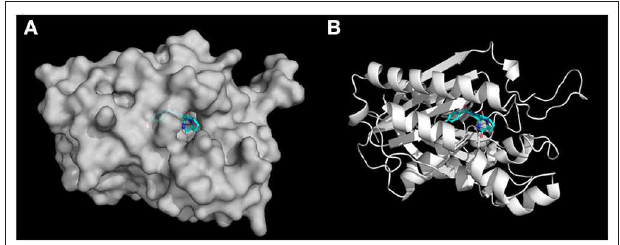
FIGURE 4 | (A) Docking simulation of binding mode between compound 3c and FabH. The receptor FabH is shown in surface view, while the structure of compound 3c is shown as sticks. (B) The 3D diagram of compound 3c interaction with the FabH active site. The proteins are shown in cartoon representation with the ligands drawn as